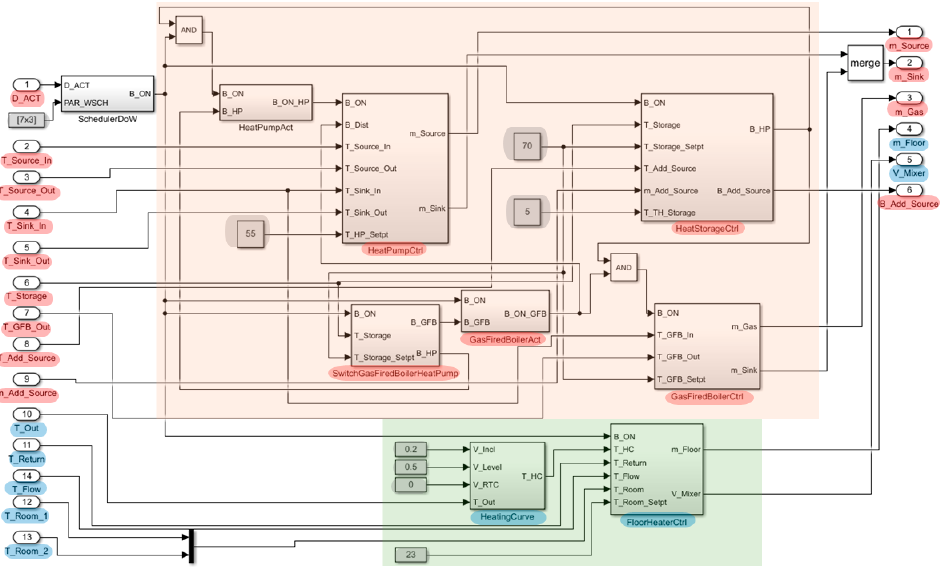
Figure 6. Automatically created baseline rule strategy for the heating system of a single room.